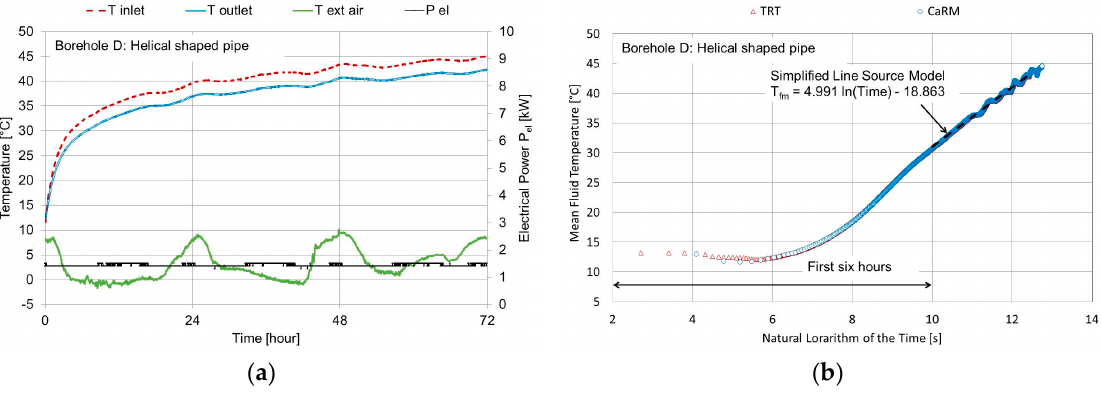
Figure 6. Thermal response test of the Borehole D which was 15 m long: ( a ) Test measurements; ( b ) Analysis with analytical and numerical models. Table 7. Equivalent ground thermal conductivity.